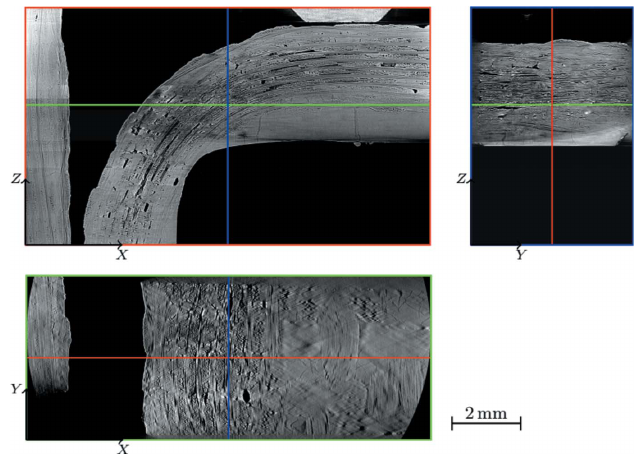
Figure 10 Sample microstructure: zoom on an XZ slice of the tomography in the initial